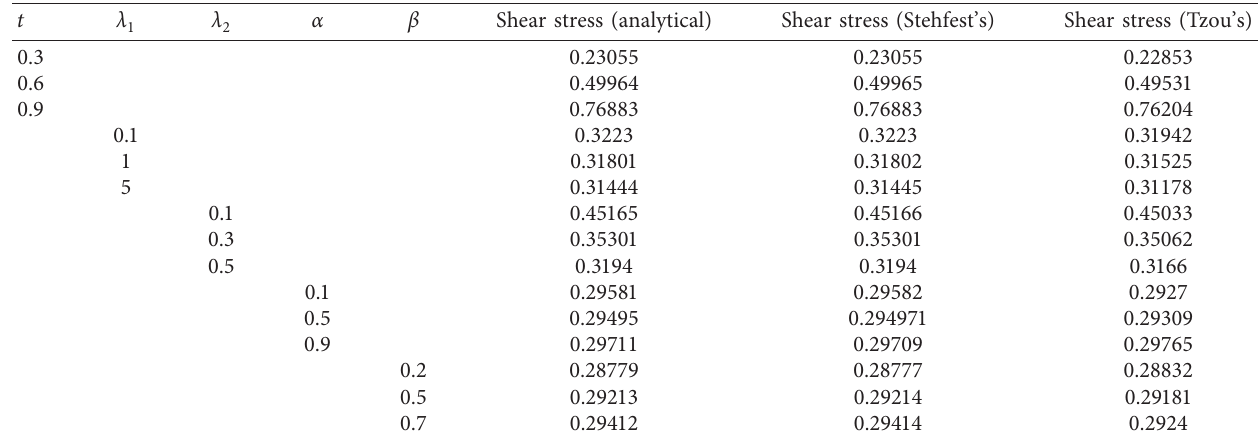
Table 4: Comparison of analytical and numerical solution for shear stresses of sin oscillation.